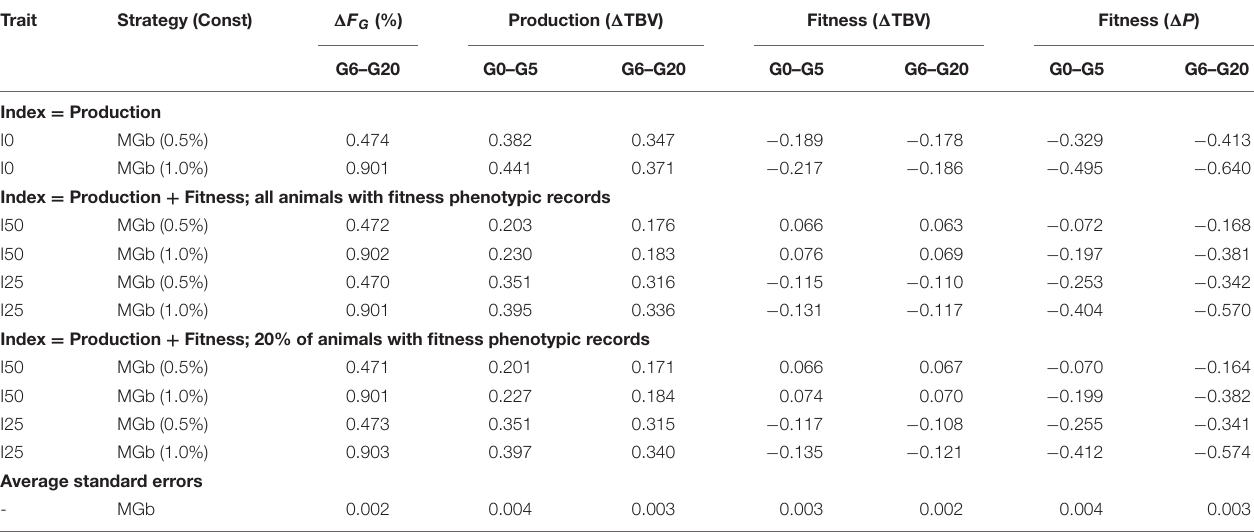
TABLE 3 | Optimum contribution of sires for maximization of genetic gain (MGb) with the desired rate of genomic inbreeding (Const): results are the observed rate of genomic inbreeding ( (cid:49) F G ), the rates of genetic improvement ( (cid:49) TBV ) in productivity and fitness and the rate of phenotypic change ( (cid:49) P ) in fitness after accounting for inbreeding depression, for selection indices emphasizing 0, 25, and 50% on fitness (I0, I25, I50). Trait